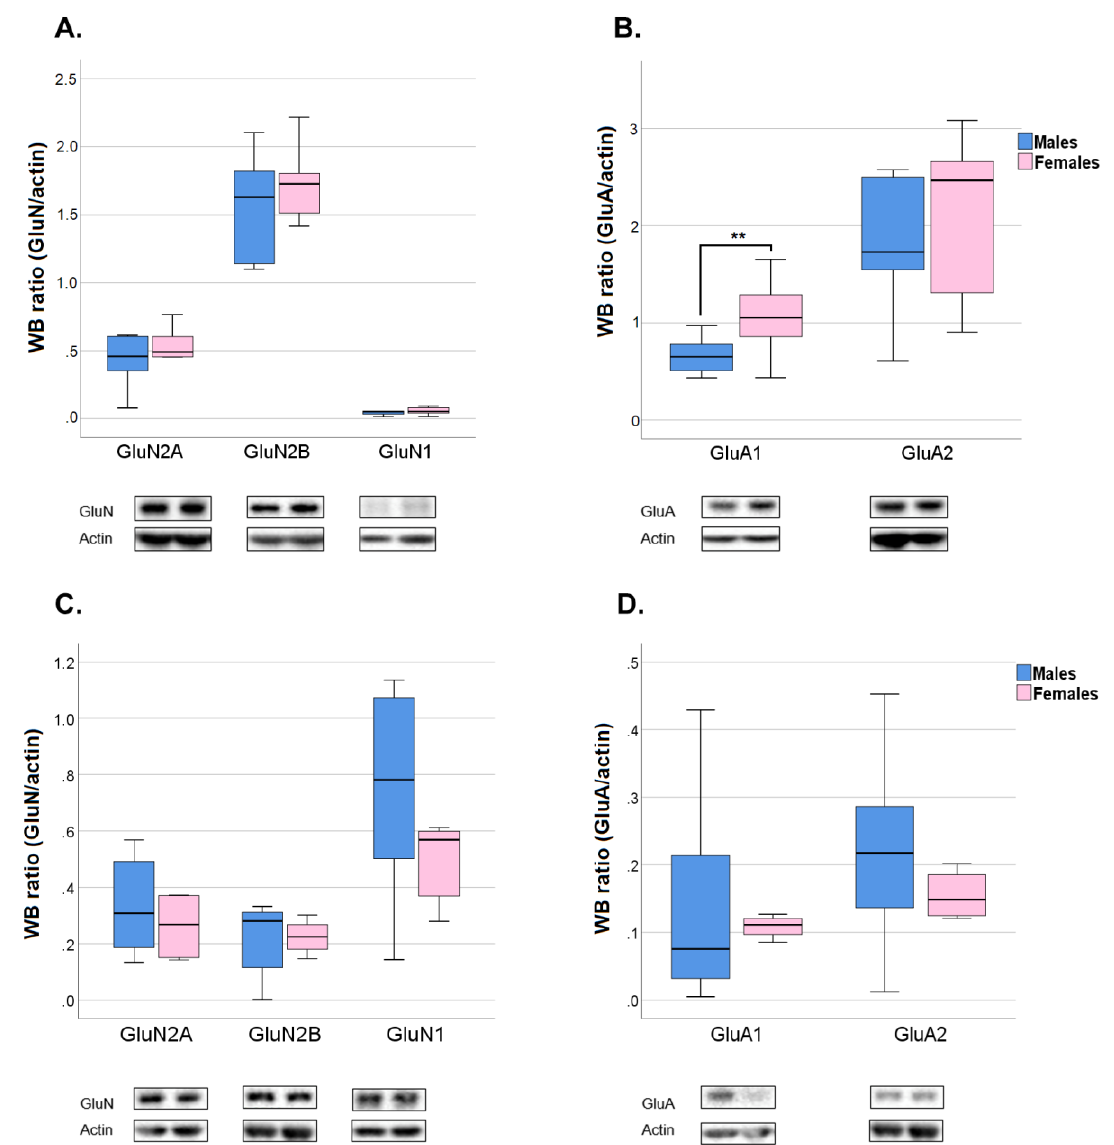
Figure7. SexDimorphismintheExpressionofN-methyl-D-Aspartate(NMDA)and α -amino-3-hydroxy- Figure 7. Sex Dimorphism in the Expression of N-methyl-D-Aspartate (NMDA) and 5-methyl-4-isoxazolepropionic acid (AMPA) Receptor Subunits in the Triton-Insoluble Fraction (TIF) α-amino-3-hydroxy-5-methyl-4-isoxazolepropionic acid (AMPA) Receptor Subunits in the of 23 and 70 Post-Natal Day Rat Hippocampi. Quantification and representative Western blots of Triton-Insoluble Fraction (TIF) of 23 and 70 Post-Natal Day Rat Hippocampi. Quantification and glutamatergic NMDA and AMPA receptor subunits in male control and female control (Veh) rats at representative Western blots of glutamatergic NMDA and AMPA receptor subunits in male control post-natal day 23 ( A , B ) and post-natal day 70 ( C , D ). Data were normalized on actin levels and are and female control (Veh) rats at post-natal day 23 ( A , B ) and post-natal day 70 ( C , D ). Data were represented as ratio on actin ( n = 5–7); ** p < normalized on actin levels and are represented as ratio on actin ( n = 5–7); ** p < 0.01.